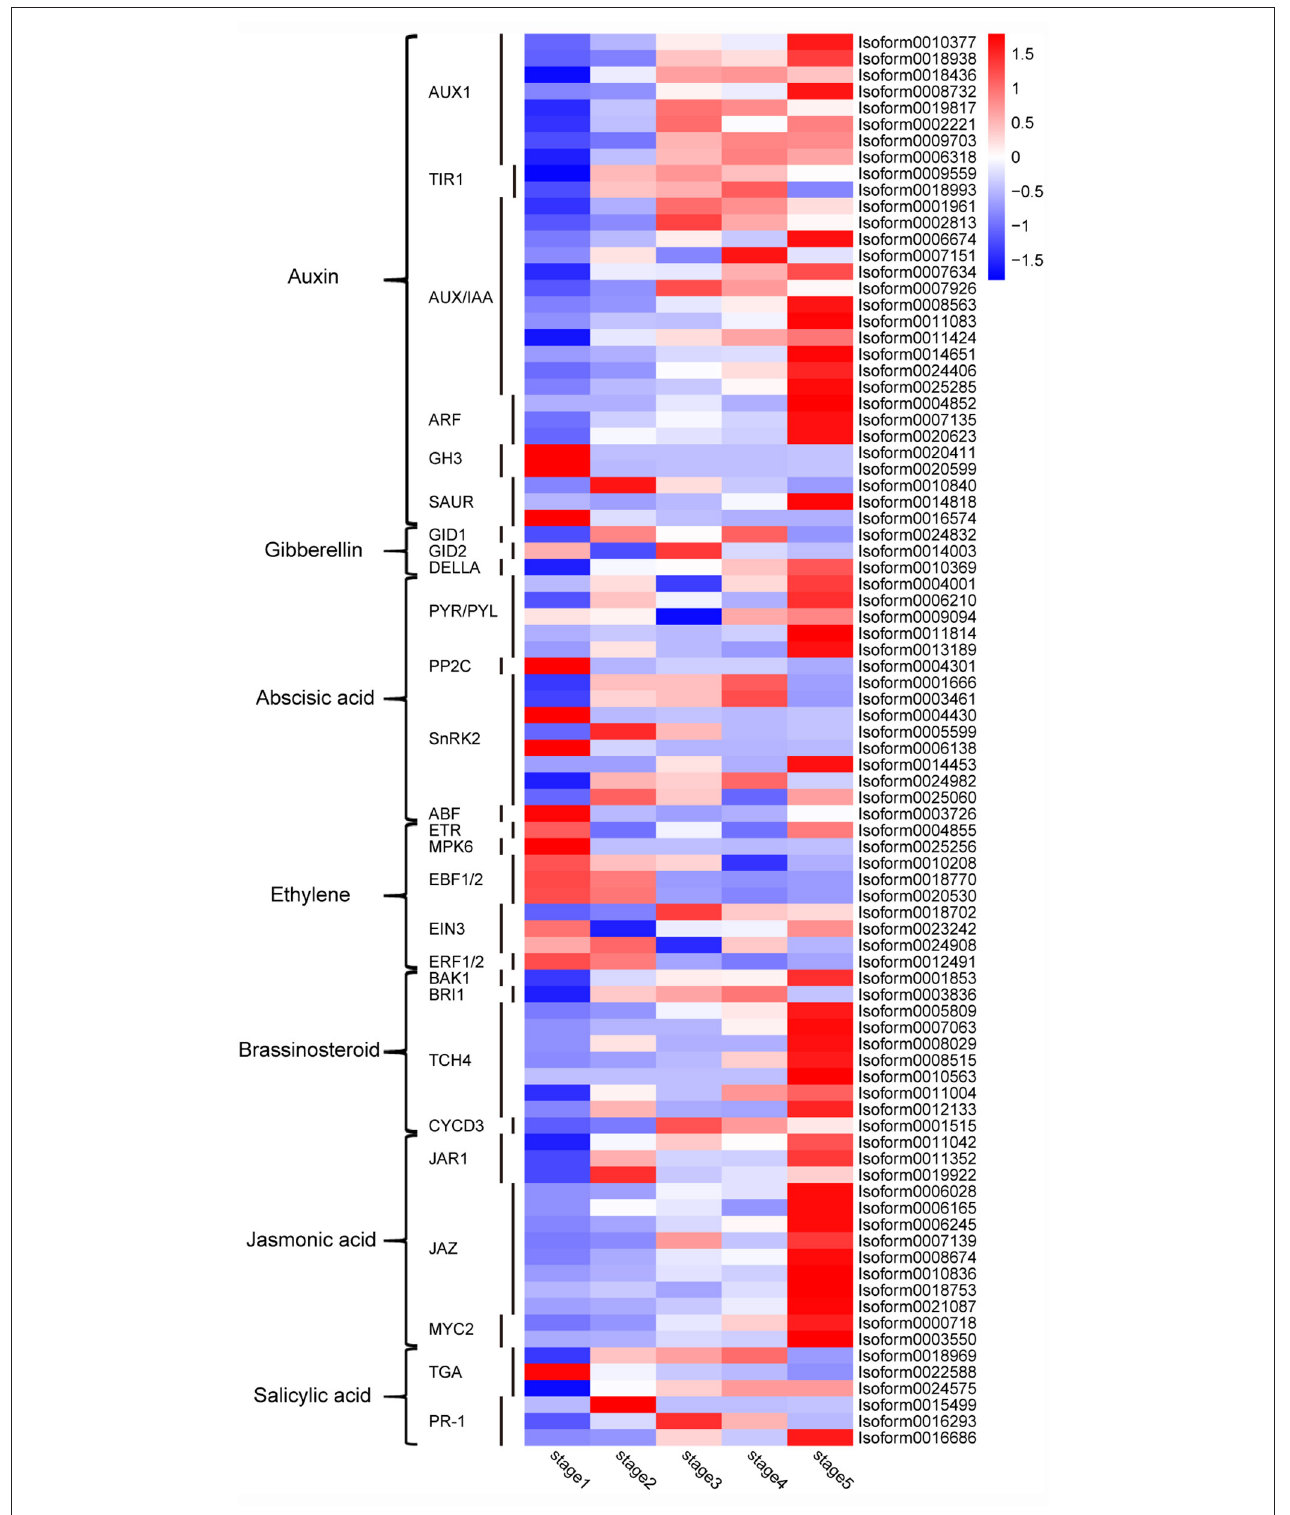
FIGURE 9 | Heatmap of expression of DEGs in the plant hormone signal transduction pathway. A color bar is presented at the top right, and the colors from blue to red indicate low to high expression. AUX1, auxin transporter protein 1; TIR1, transport inhibitor response1; AUX/IAA, auxin/indole-3-acetic acid; ARF, auxin